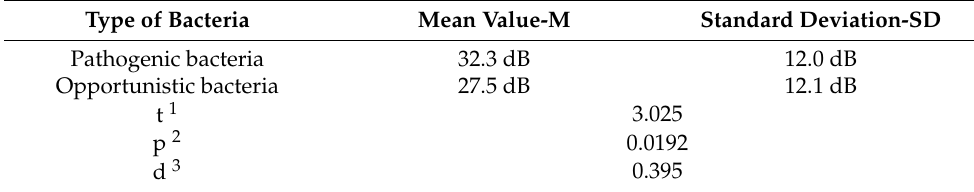
Table 8. Degree of hearing impairment depending on the type of cultured bacteria. Type of